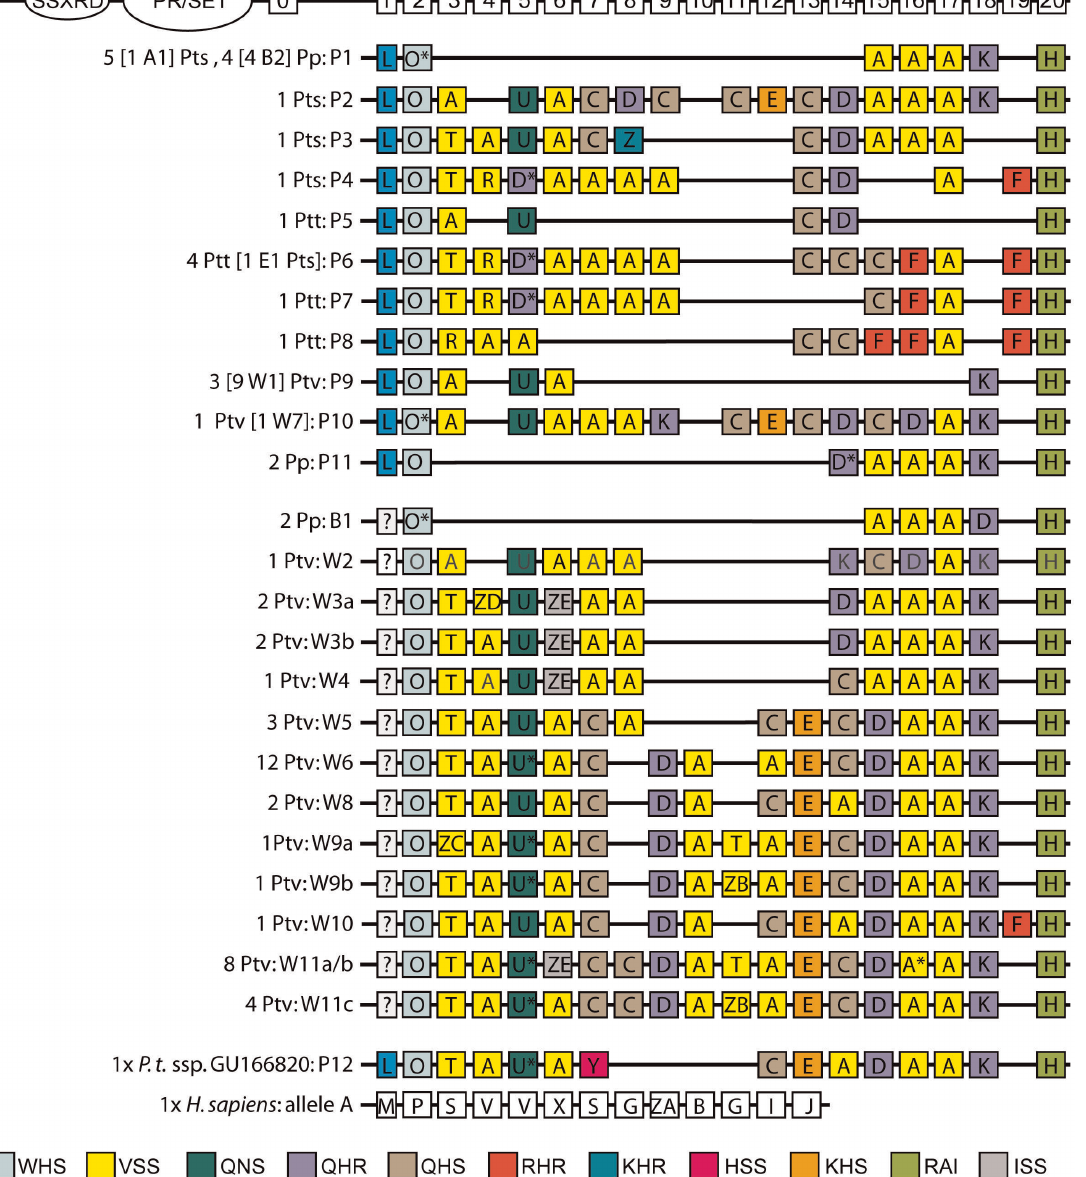
Figure 1. Schematic representation of PRDM9 domains and allelic variation in Pan . The top block depicts alleles identified in this study. The second block shows the additional alleles characterized by Auton et al. [36]. The four alleles common to both studies are shown in the top block, with the number of occurrences and the corresponding (sub-)species given in square brackets. Pp = Pan paniscus, Ptv = P. troglodytes verus , Ptt = P. t. troglodytes , Pts = P. t. schweinfurthii . Different ZnF repeats are coded by letters and repeats marked with a * differ from those with the same letter code by one, two, or three synonymous substitutions. The underlying nucleotide sequence, as shown in Figure 2, of O* is n or zg, D* represents q, A* is zf and U* represents w. Colors correspond to the AA residue combination at positions 2 1, 3 and 6 of the ZnFs, as given in the legend. Residue position 2, which also plays a role in DNA binding is fixed (serine) and therefore not shown. Human allele A is depicted for reference.